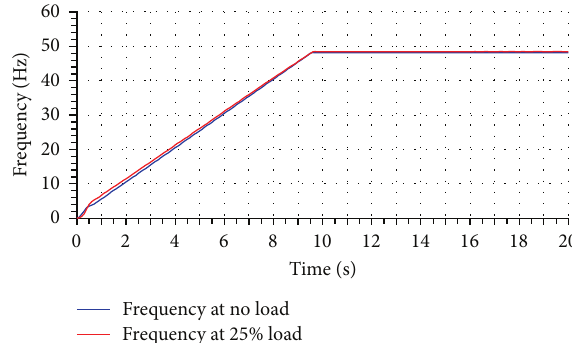
Figure 7: Frequency variation of IM drive during starting at different loads and 1440rpm speed.